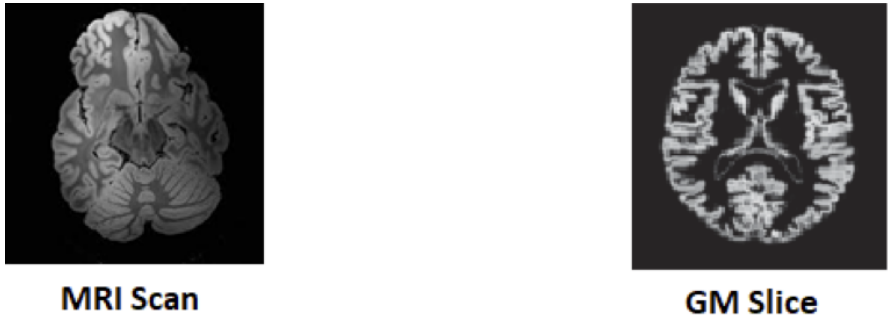
Figure 1. MRI to 2D GM